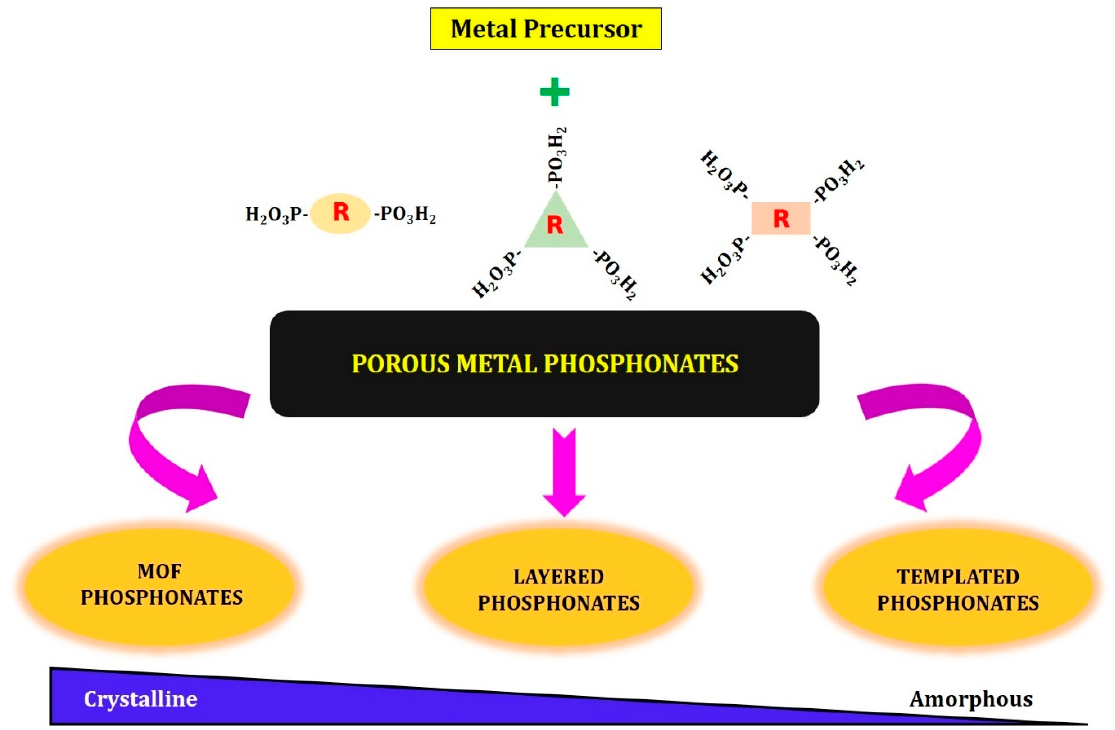
Figure 1. Scheme for classifying porous metal phosphonates based on structural/morphological properties.